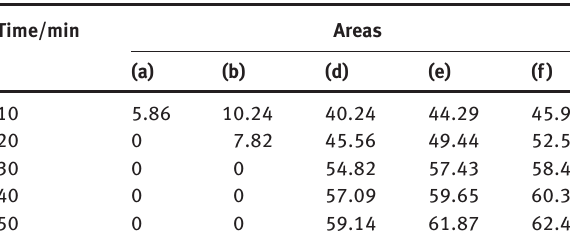
Table 3: Variations of volume fraction of V-containing spinel phase in different areas of the samples with different time at G =